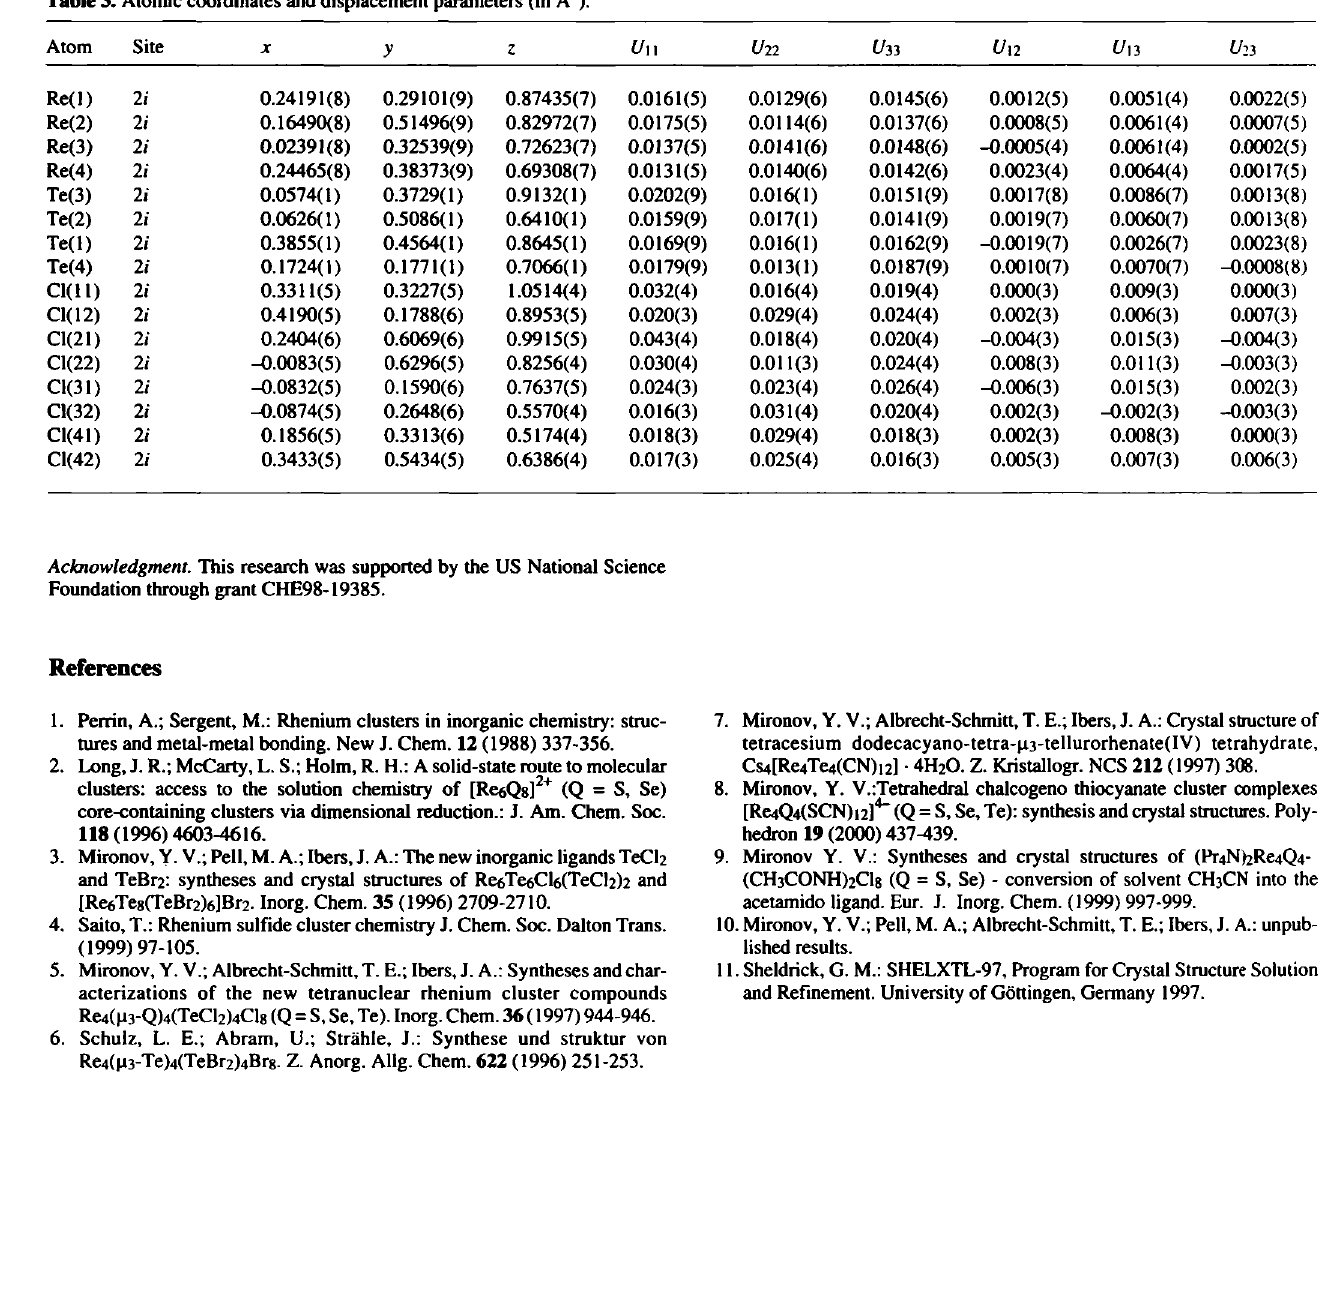
Table 3. Atomic coordinates and displacement parameters (in Ä 2